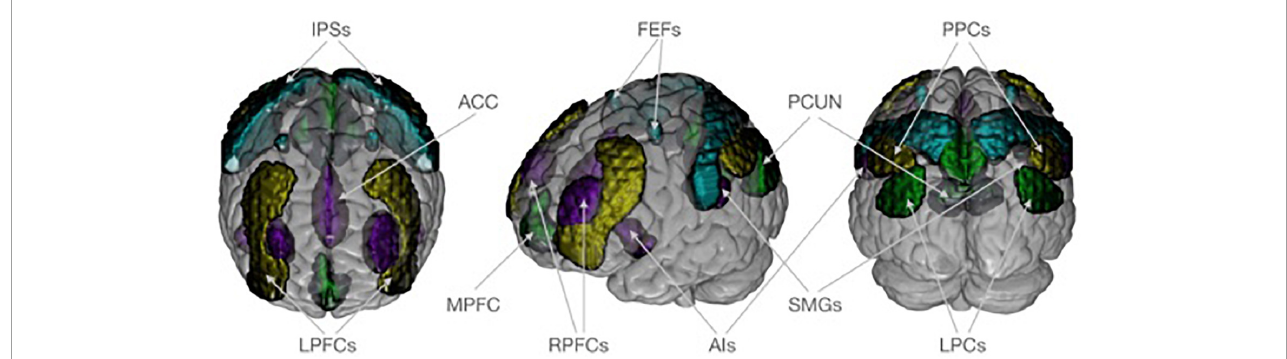
FIGURE1 Neuroanatomical visualization of four target networks, according to CONN’s standard atlas. The default mode network is shown in dark green and consists of the medial prefrontal cortex (MPFC), the bilateral lateral parietal cortex (LPCs), and the precuneus (PCUN). The saliency network (purple) includes the anterior cingulate cortex (ACC) as well as the bilateral anterior insula (AIs), rostral prefrontal cortex (RPFCs), and supramarginal gyrus (SMGs). The dorsal attention network (turquoise) consists of frontal eye field (FEFs) and intraparietal sulcus (IPSs) bilaterally. The frontoparietal network (yellow) comprises both the right and left lateral prefrontal cortex (LPFCs) and posterior parietal cortex (PPCs). Regions of interest are plotted on an MNI standard brain in anterior, lateral, and posterior view using MRIcroGL